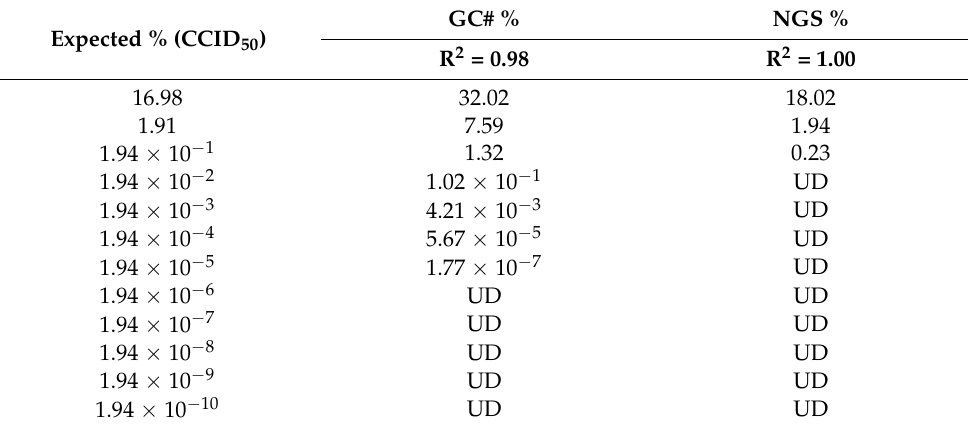
Table 4. Correlation between the Sabin 2 percentages calculated from the spiked samples based on CCID50 and genome copy number, and by using